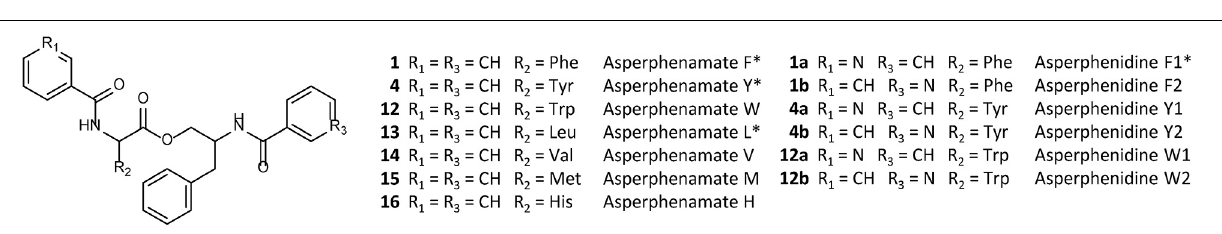
( δ H 6.69), a methine at H-2 (cid:48) ( δ H 5.04) and a methylene at